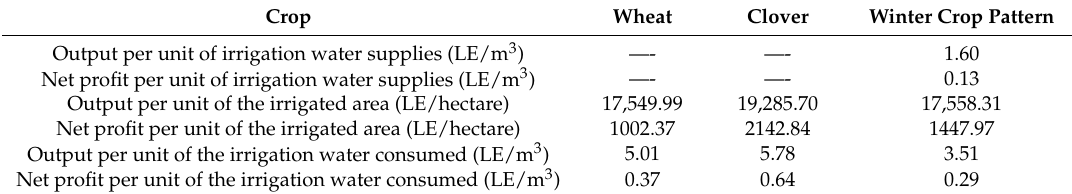
Table 7. Economic indicators for the Al-Qased command area during the winter season (from November 2015 to May 2016). Wheat Winter Crop